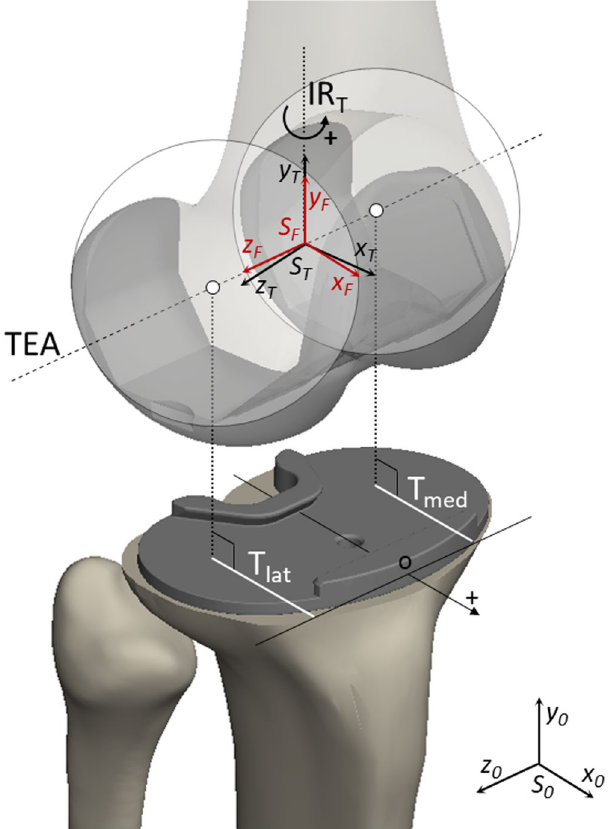
Figure 4. Defined reference systems to measure the tibial internal rotation (IR T ) and the anteroposterior translation of each condyle. It can be seen the transepicondylar axis (TEA) passing through the centers (white points) of two spheres inscribing the femoral condyles. Also, the two body-fixed reference systems for the femur (S F in red) and the tibia (S T in black) are showed. These are located on the TEA in the middle of the centers of the spheres and used to measure the IR T as the relative rotation of S T with respect to S F along the y direction. At the beginning of the simulation, S F and S T are coincident with the y axis along the y 0 axis of the global reference system (S 0 ). The anteroposterior positions of both lateral (T lat ) and medial (T med ) condyle are obtained as the projection (white lines) on the tibial tray of the minimal distance between the center of the spheres and the anterior edge of the tibial tray. The condyle position is measured along an axis pointing anteriorly and having origin at the anterior edge of the tibial tray (point O). Therefore, measured positions result